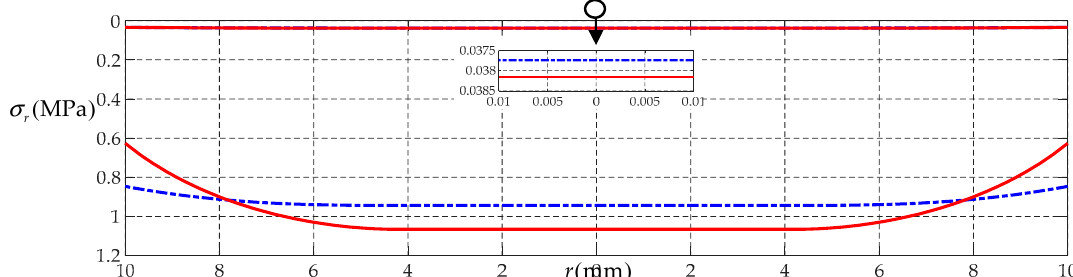
Figure 5. Variations of σ r with r for the gap g = 0.5 mm and the contact radius b = 4 mm corresponding to q = 0.001327 MPa and 0.001322 MPa calculated by the solutions presented in [28] (the dash-dotted lines) and presented here (the solid lines), and for g = 2.5 mm and b = 4 mm corresponding to q = 0.1654 MPa and 0.1576 MPa calculated by the solutions presented in [28] (the dash-dotted lines) and presented here (the solid lines).